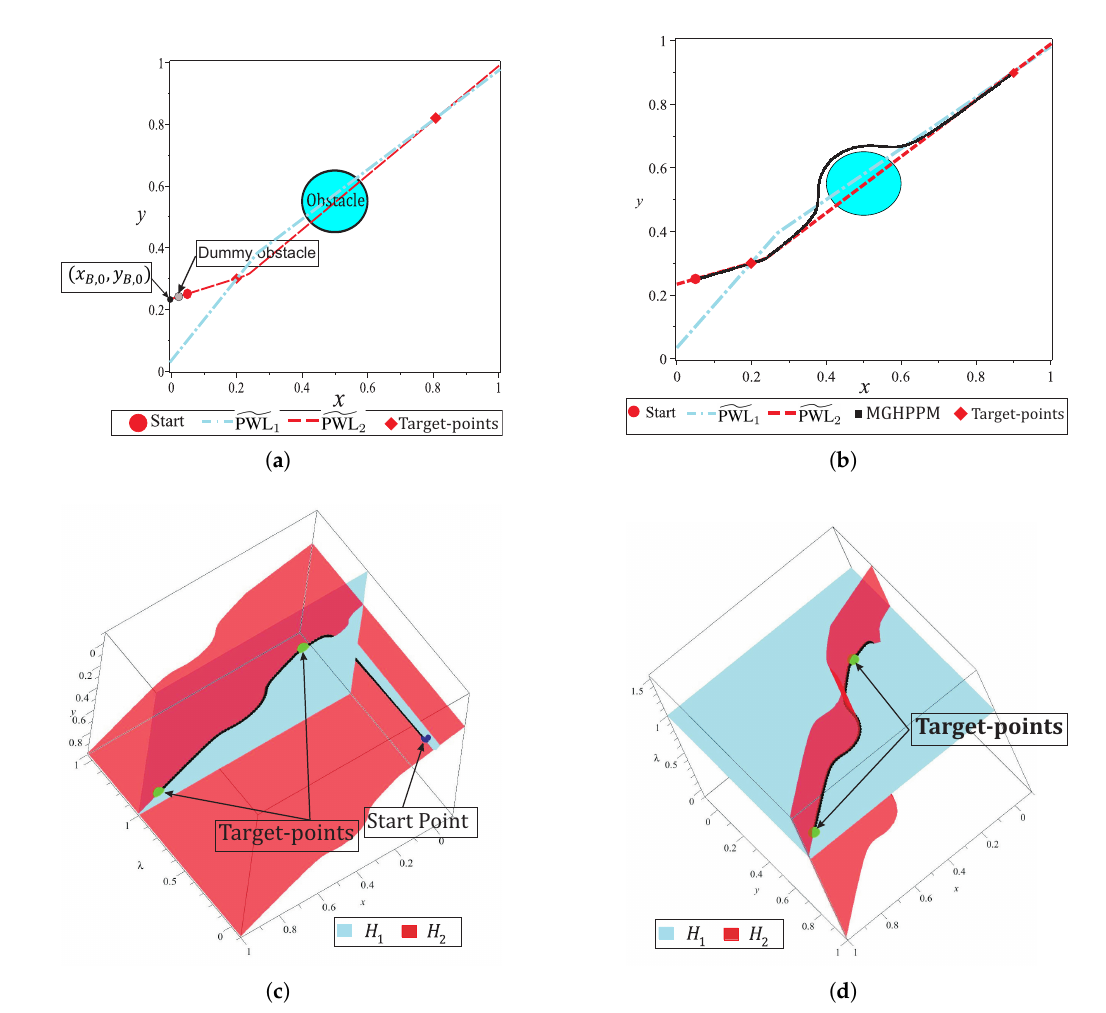
Figure 13. Map with added dummy obstacle. ( a ) Environment map with dummy obstacle and two target-points. ( b ) 2-D representation solution path. ( c ) [3-D representation (View 1) solution path. ( d ) 3-D representation (View 2) solution